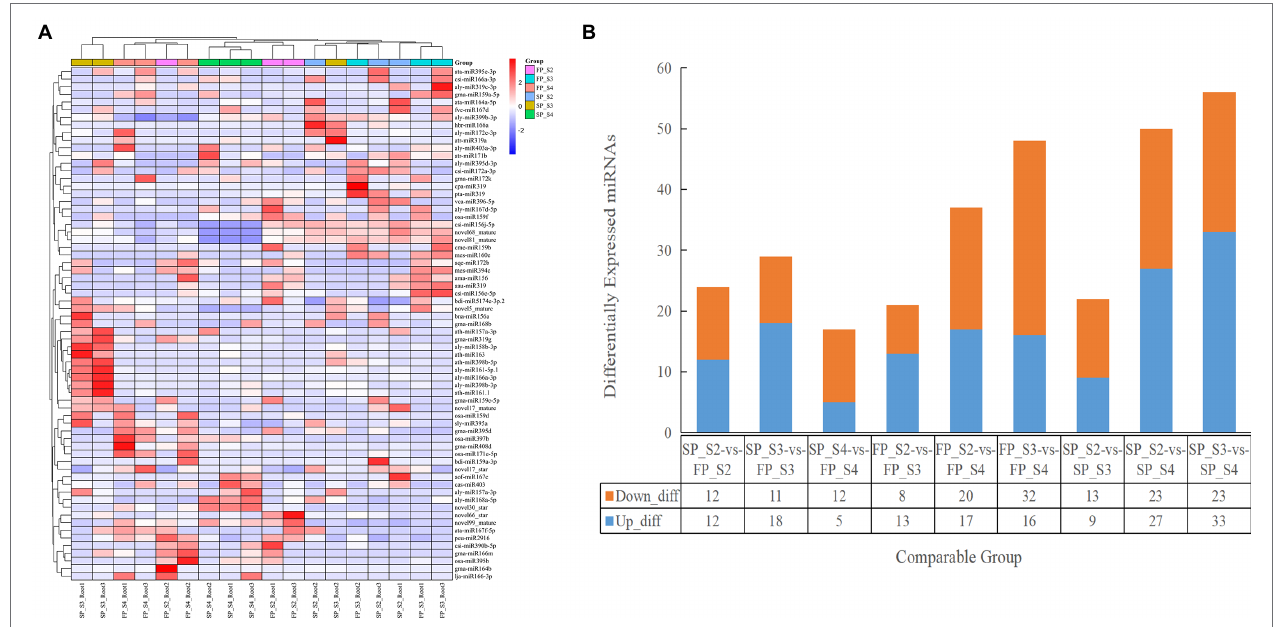
FIGURE 3 | The expression profile of differentially expressed miRNAs (DEMIs) at different growth periods of patchouli roots under continuous cropping stress. (A) Hierarchical clustering analysis of DEMIs. (B) The number and characteristics of DEMIs among different